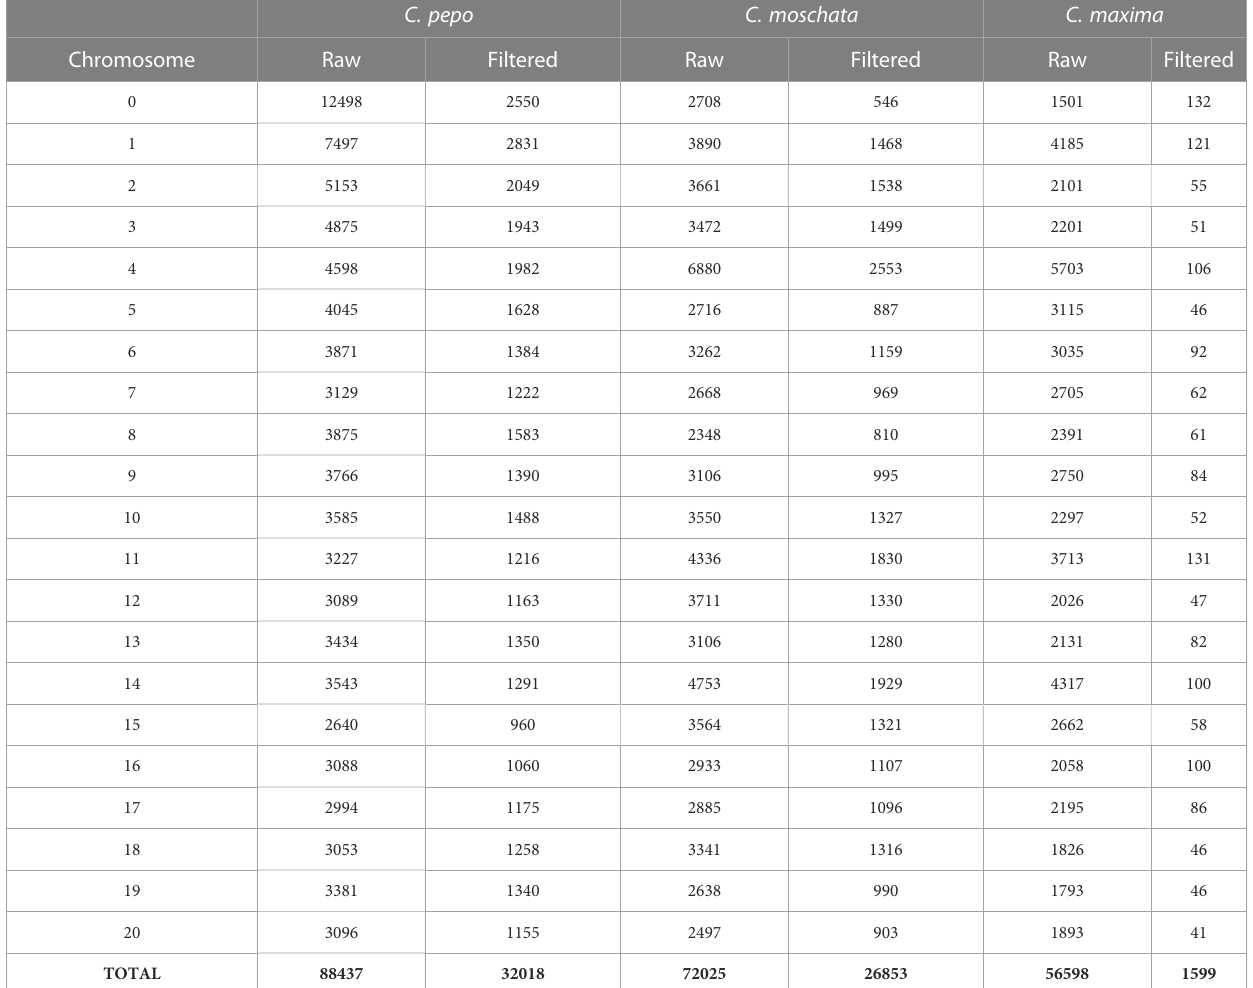
TABLE 1 Distribution and number of raw and fi ltered SNPs per chromosome for each